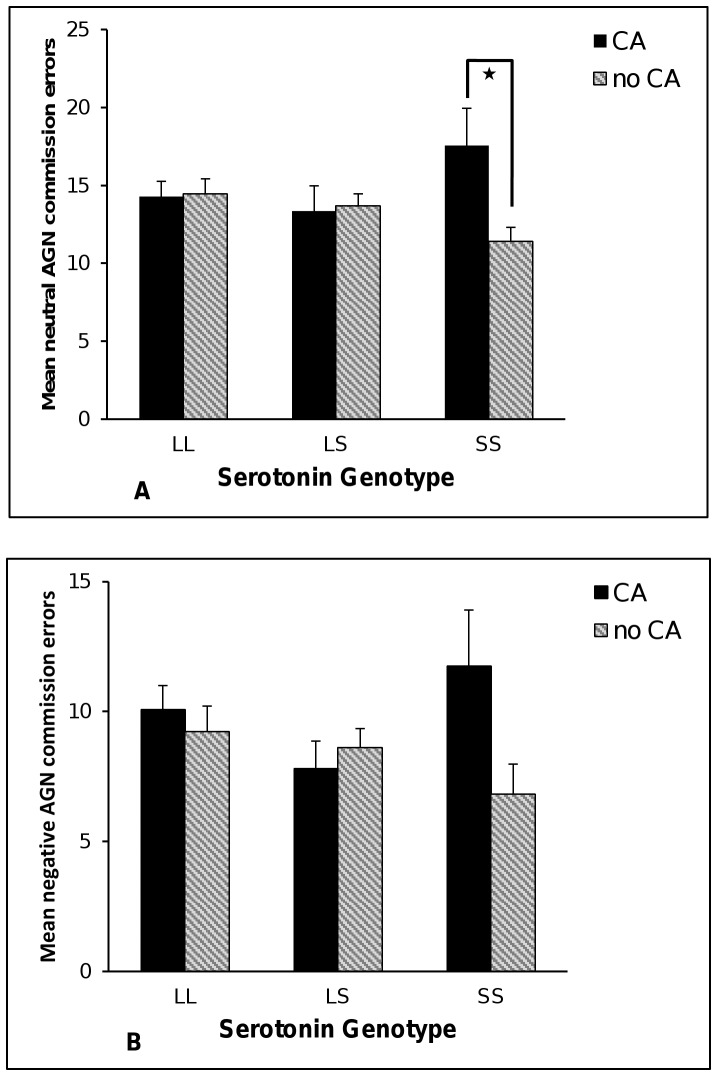
Mean number of emotionally valent neutral and negative commission errors by gene variants in 5-HTTLPR and early childhood adversities (CA).Error bars represent ±1 SE of the mean. * p<0.05.